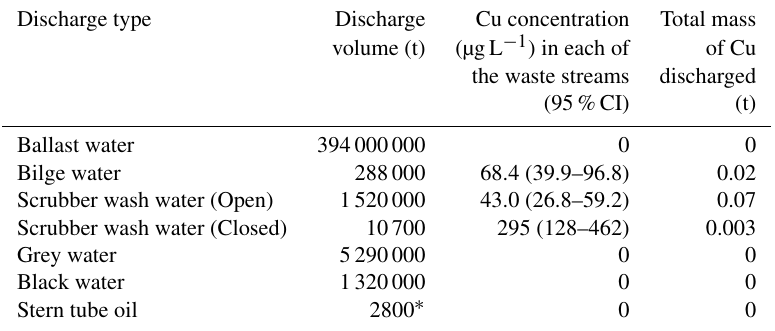
Table 7. Volume discharges from STEAM for Baltic Sea shipping in 2012 (in tonnes), Cu concentration in discharge samples (micrograms per litre) and calculated total discharged mass of Cu (in tonnes) into the Baltic Sea.